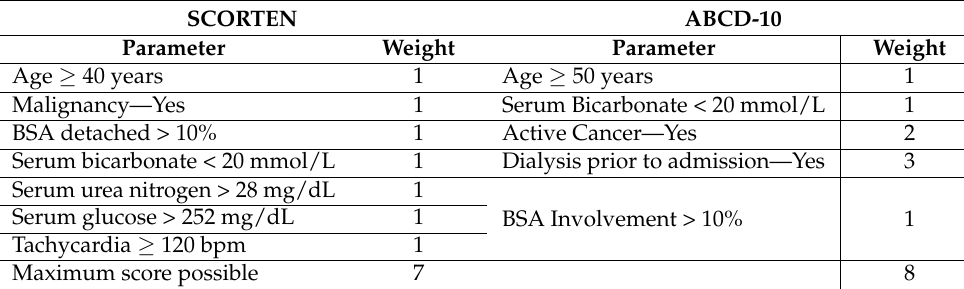
Table 5. SCORTEN and ABCD-10 Scoring Systems.